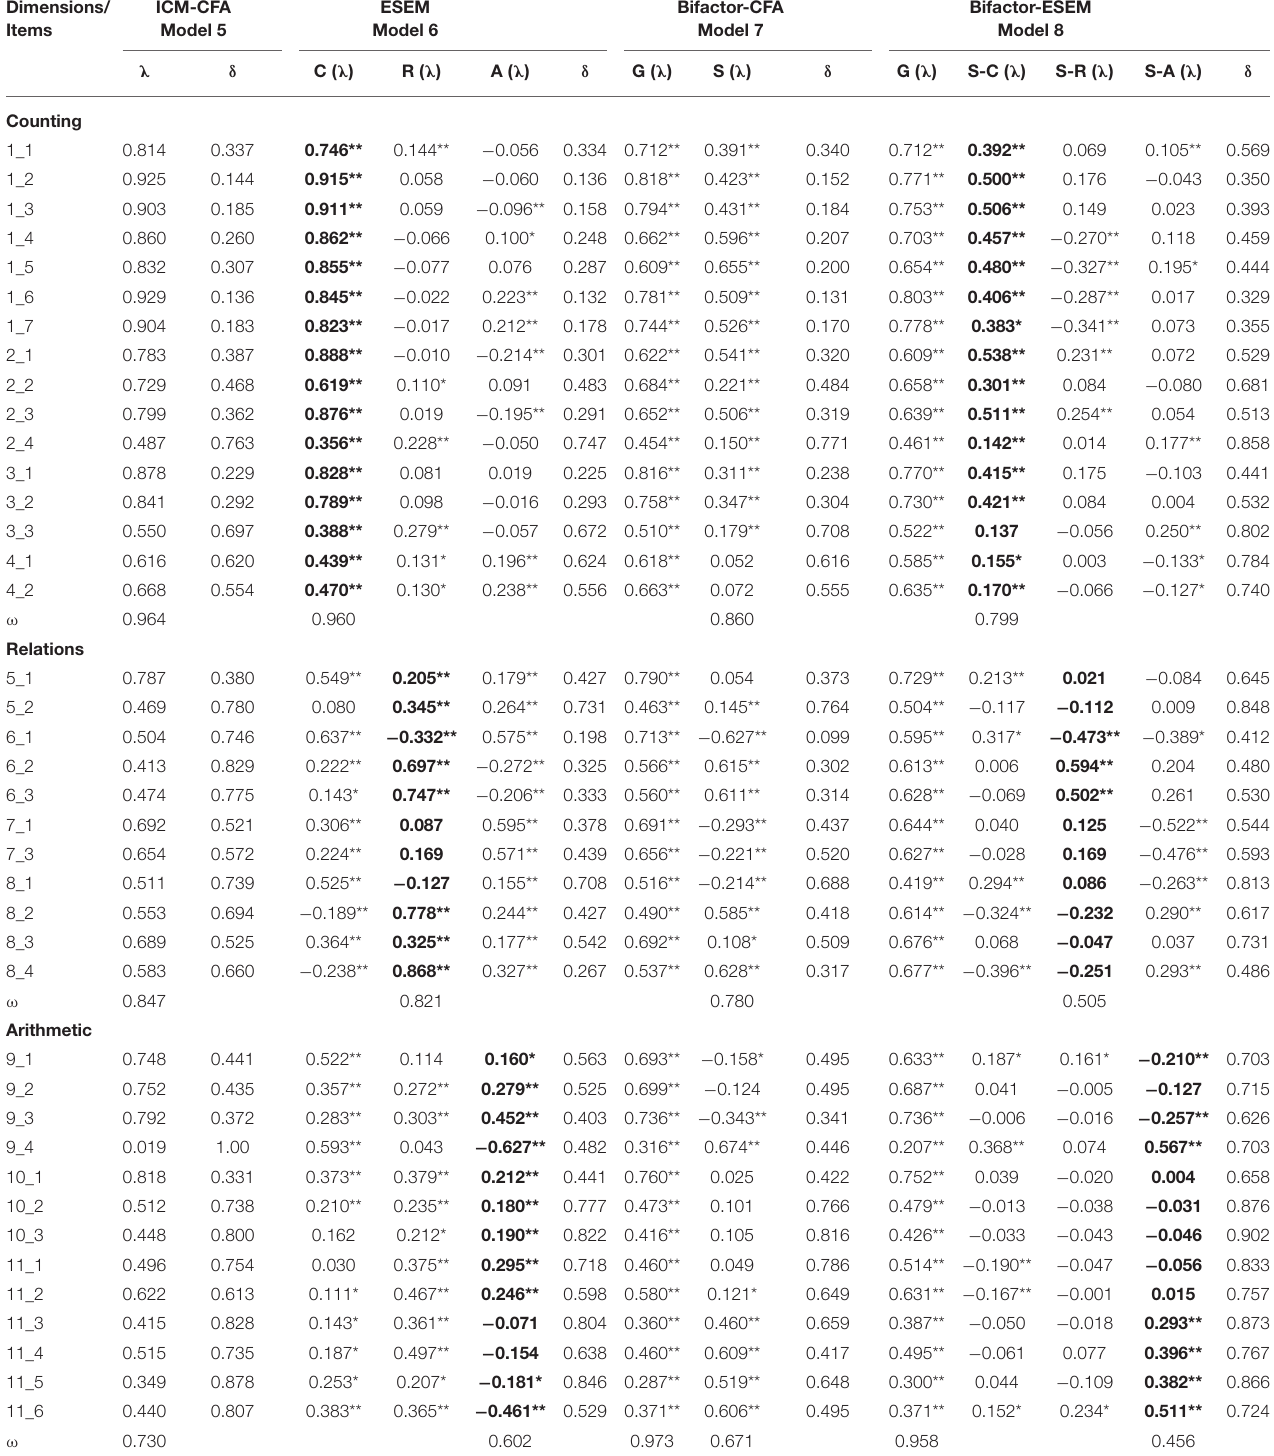
TABLE 4 | Standardized factor loadings ( λ ), uniquenesses ( δ ) and omega ( ω ) for Model 5 to Model 8. Dimensions/